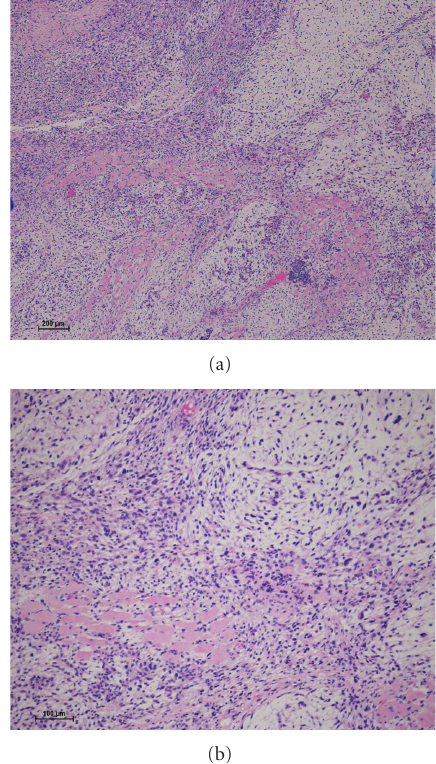
Figure 3: Hematoxylin and eosin stain of the resected tumor (a) × 40 and (b) × 100. Spindle-shaped tumor cells were arranged within the loose myxoid stroma. Only a few atypical mitoses and necroses were found. The histological grade was determined as grade